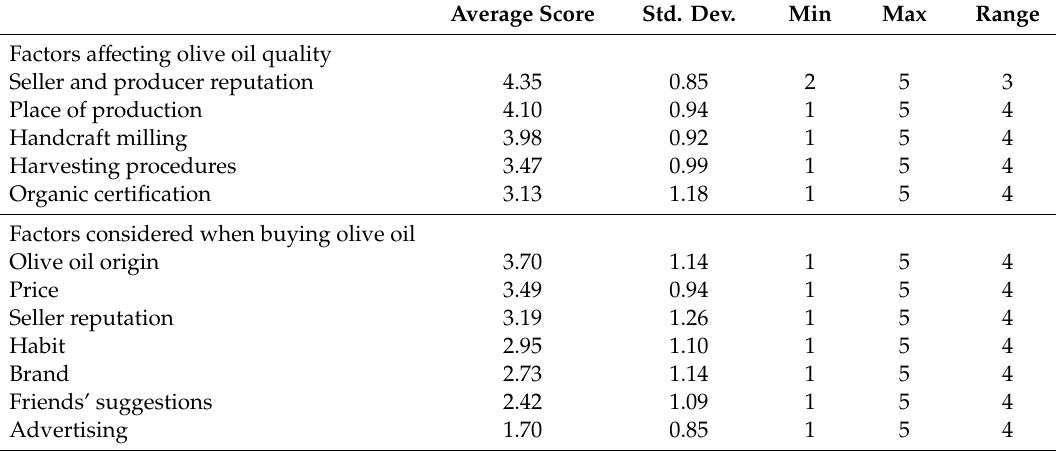
Table 3. Factors a ff ecting olive oil quality and factors considered when buying olive oil. Average Score Std.